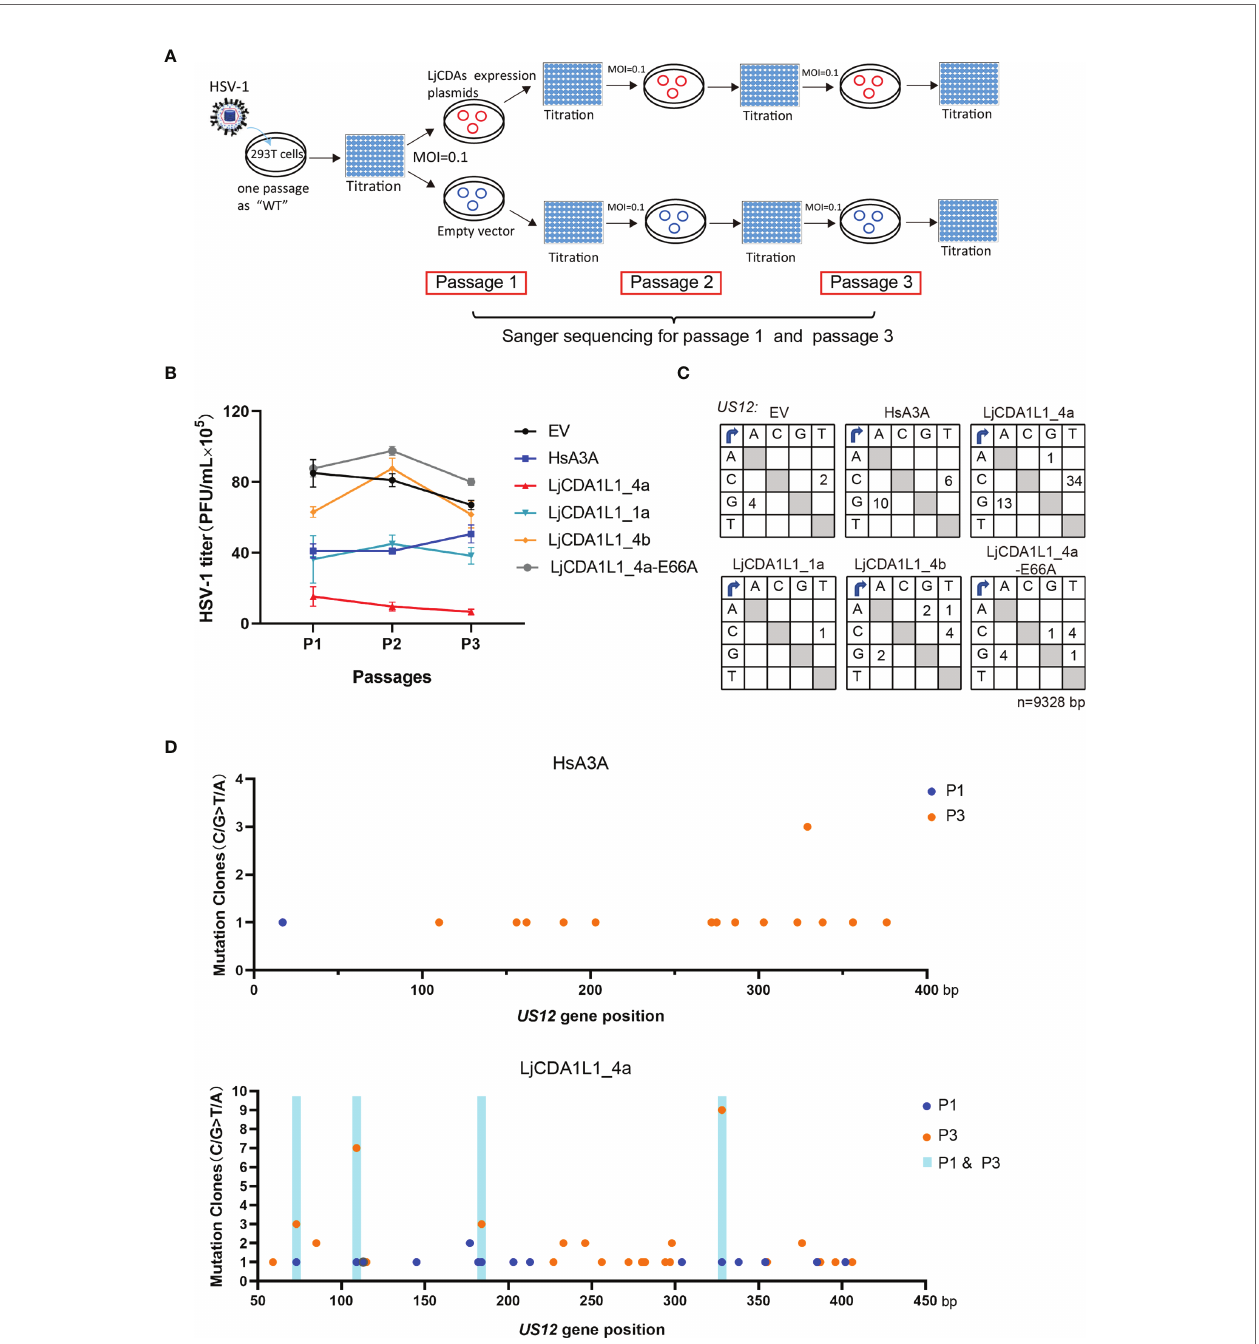
FIGURE 6 | The antiviral activity of the LjCDA1L1 subgroup to HSV-1. (A) Schematic diagram of the HSV-1 passaging experiment. 293T cells were transfected with LjCDA expression constructs and then infected by HSV-1 (MOI = 0.1 PFU/cell). Then, HSV-1 particles in the cell supernatants were harvested to infect the fresh 293T cells which were transfected with indicated LjCDA constructs. Such experiment was repeated three times. (B) PFUs of HSV-1 harvested from the supernatants of LjAID/APOBEC and HsA3A proteins expressing 293T cells at 48 h after infection by HSV-1 at 0.1 MOI from three passages. Error bars denote ± SD. (C) Mutation matrices for the US12 gene of HSV-1 extracted from 293T cells expressing LjAID/APOBEC and HsA3A proteins from the third passages. n = 9,328 bp. (D) Mutation clones plotted against nucleotide position of the US12 gene of HSV-1 extracted from 293T cells expressing LjCDA1L1_4a and HsA3A proteins from passage 1 and passage 3. The mutation sites present only in passage 1 are indicated by blue dots, while the mutation sites present only in passage 3 are indicated by orange dots. The mutation sites present both in passage 1 and passage 3 are indicated by shaded